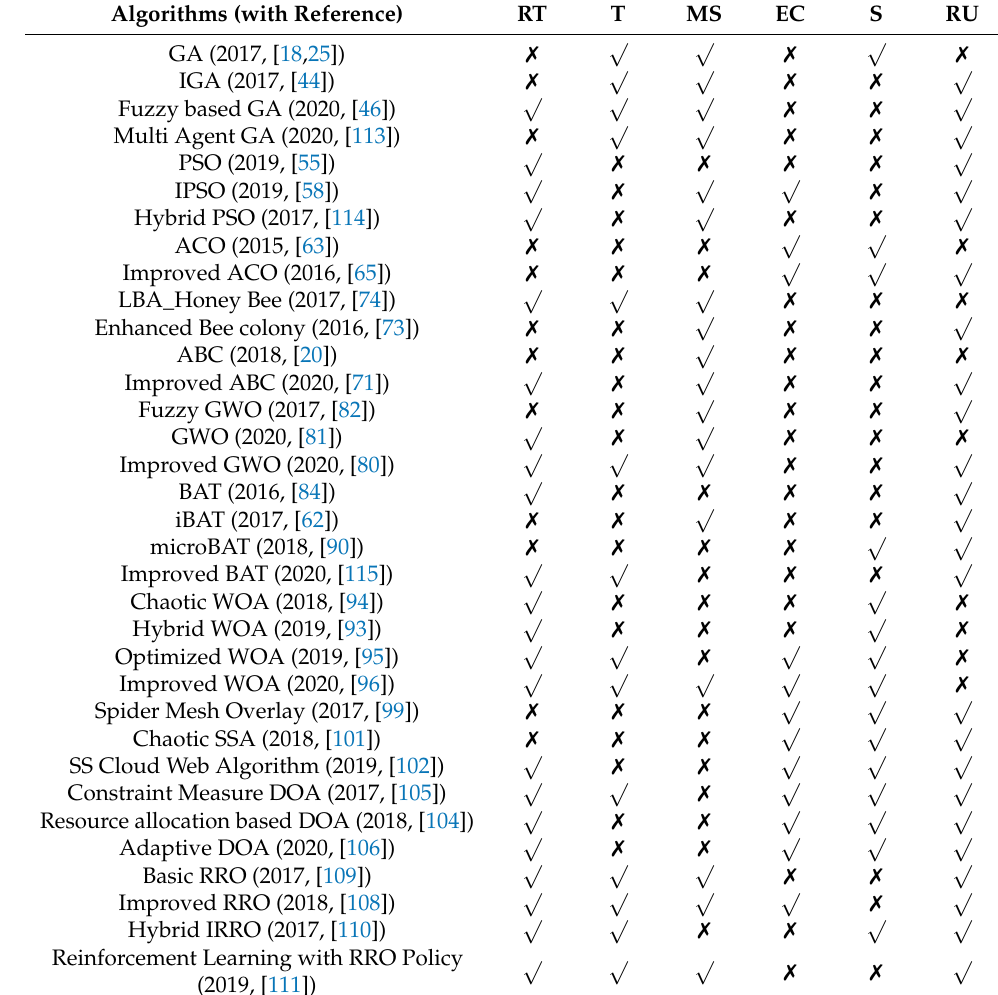
Table 17. Comparative analysis based on improved quality